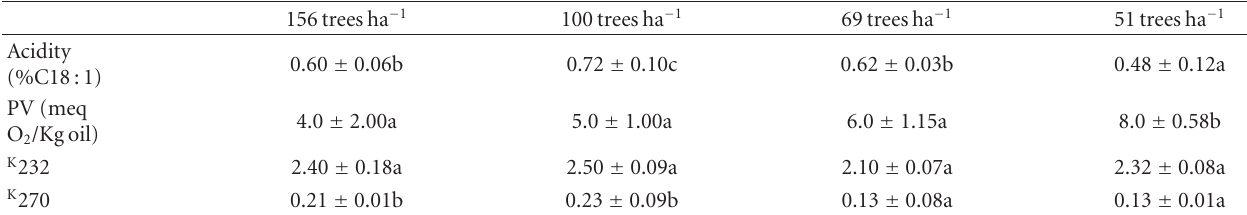
Table 1: Quality parameters of Chemlali olive oil samples from the four planting densities.